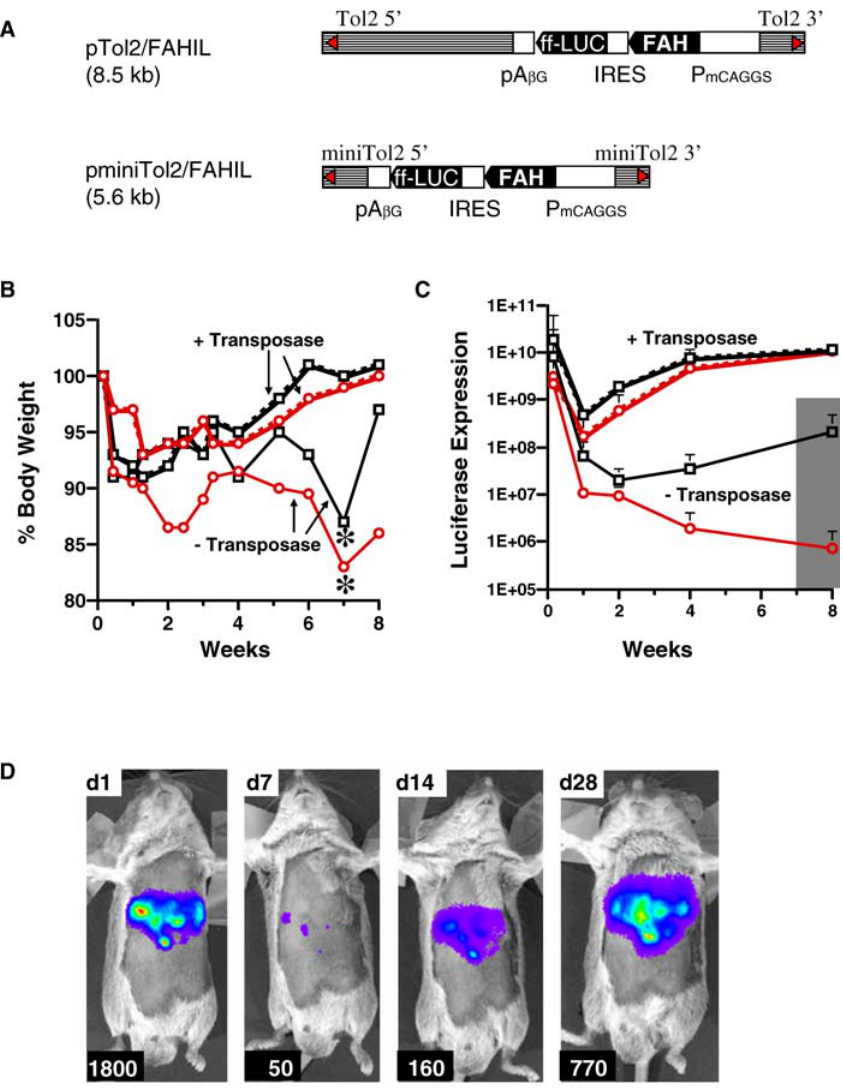
Figure 3. Tol2 -Mediated, Long-term Expression and Gene Correction of Murine Model of Tyrosinemia Type 1 (A) Schematic diagram of Tol2 transposons used for injections of FAH-deficient mice. The full-length (pTol2/FAHIL) and minimal (pminiTol2/FAHIL) versions of the transposon provide expression of both FAH and luciferase as products of a single message; pCMV-GFP served as a co-delivered control plasmid while pCMV-Tol2 provided a source of transposase protein. PmCAGGS [51], minimal chimeric CMV enhancer/chicken beta-actin fusion promoter; pA b G, rabbit beta-globin poly(A); ff-LUC, firefly luciferase; FAH, mouse fumarylacetoactate hydrolase cDNA; IRES, encephalomyocarditis virus internal ribosome entry site. Then 10 mg of pTol2/FAHIL or pminiTol2/FAHIL transposon DNA plus pCMV-GFP or -Tol2 (10 mg each) was administered by rapid, high-volume tail vein injection into sedated FAH-deficient mice ( n ¼ 3 to 5 per group). (B) The mean percentage body weight for animals in each treatment group, to determine the progression of liver disease. An asterisk ( * ) indicates the time when NTBC was readministered in drinking water to prevent mortality of mice that did not receive Tol2 transposase. (C) In vivo luciferase activity levels, assayed at indicated time points by whole body imaging and recorded as photons emitted per second as described in Materials and Methods. The time courses of changes in body weight or in vivo luciferase enzyme activity are shown for groups of animals co-infused with pTol2/FAHIL and GFP (squares) or Tol2 transposase (circles), or with pminiTol2/FAHIL plus GFP (triangles) or Tol2 transposase (plus sign). The mean percentage luciferase activity at any given time point is relative to that observed at 24 h for pminiTol2/FAHIL, which demonstrated the highest transient level of luciferase activity. The 8-wk measurement of no-transposase control animals is shaded because they required administration of NTBC for survival at 7 wk. (D) Images of mice infused with pminiTol2/FAHIL plus pCMV-Tol2 at indicated times (in days; upper left box), showing tissue regeneration as seen by increasing intensity of luciferase enzyme activity detected at a location corresponding to the liver. In vivo luciferase activity levels are reported at the bottom of each image (lower left box) as photons emitted per second ( 3 10 6 ).